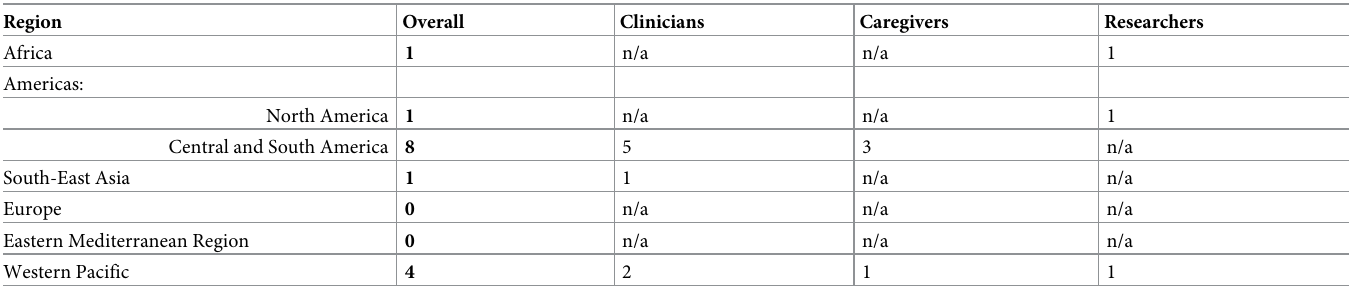
Table 1. Characteristics of participants in the focus group discussions.